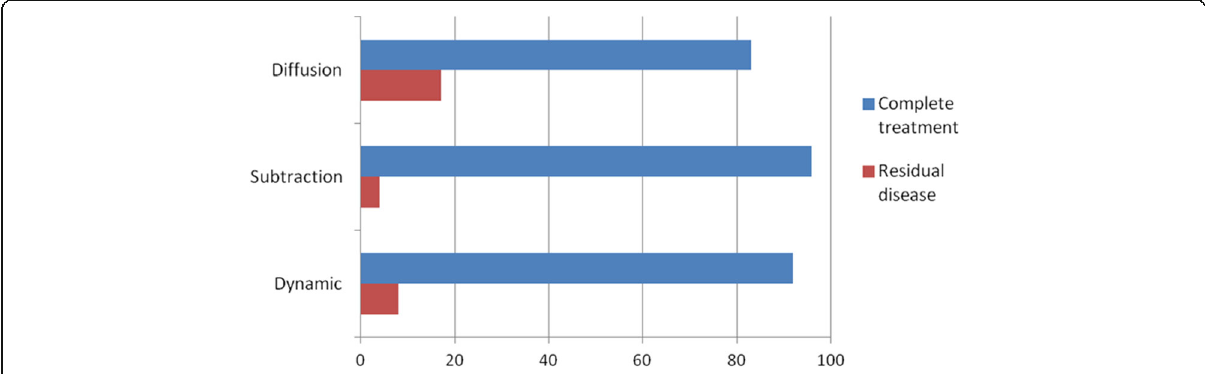
Fig. 4 Horizontal graph showing the correlation of reader 2 findings to standard of reference (expressed as percentage)